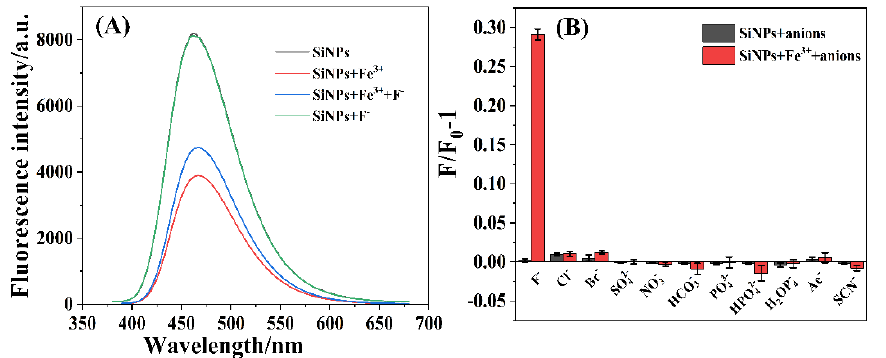
Figure 5. ( A ) Fluorescence spectra of SiNPs (black line), SiNPs+Fe 3+ (red line), SiNPs + Fe 3+ + F − (blue line), and SiNPs + F − (green line); ( B ) anion selectivity assays of the SiNPs and SiNPs–Fe system with anion concentration of 1 mmol ∙ L − 1 at 370 nm excitation.